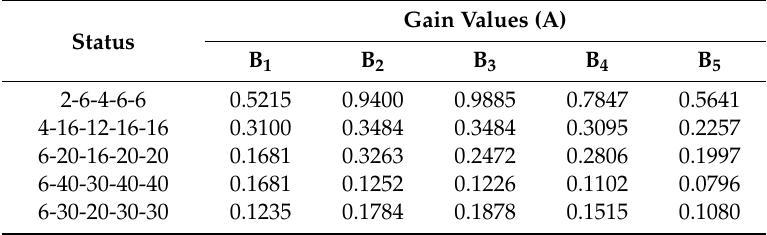
Table 4. Gain values of all GF-4 bands under di ff erent